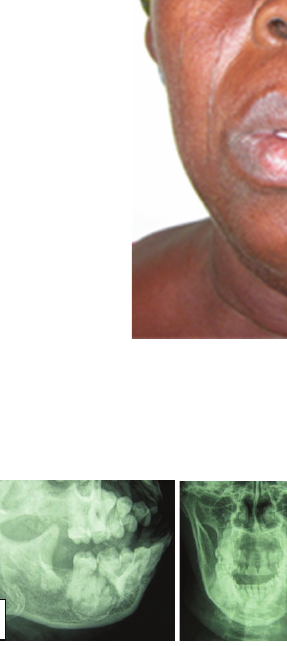
Figure 2: Oblique lateral views of the mandible and posteroanterior view of the jaws for case 1 demonstrating an osteolytic lesion (with centrifugal radiopaque spikes) within which the faint presence of an irregular, shapeless mass of radiopacity can be seen–white